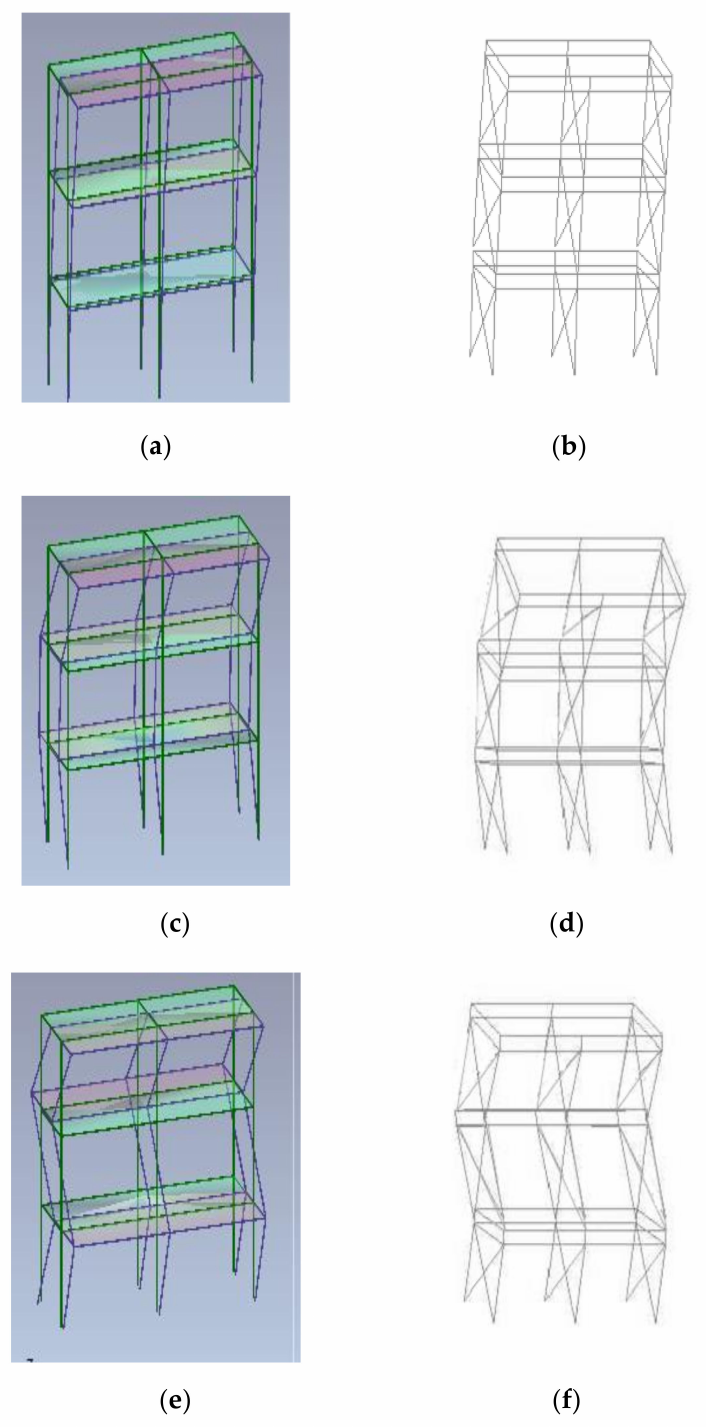
Figure 7. Comparison of experimental (Artemis) and numerical (OpenSees) modal shapes [42]. ( a ) First experimental modal shape; ( b ) First numerical modal shape; ( c ) Second experimental modal shape; ( d ) Second numerical modal shape; ( e ) Third experimental modal shape; ( f ) Third numerical modal